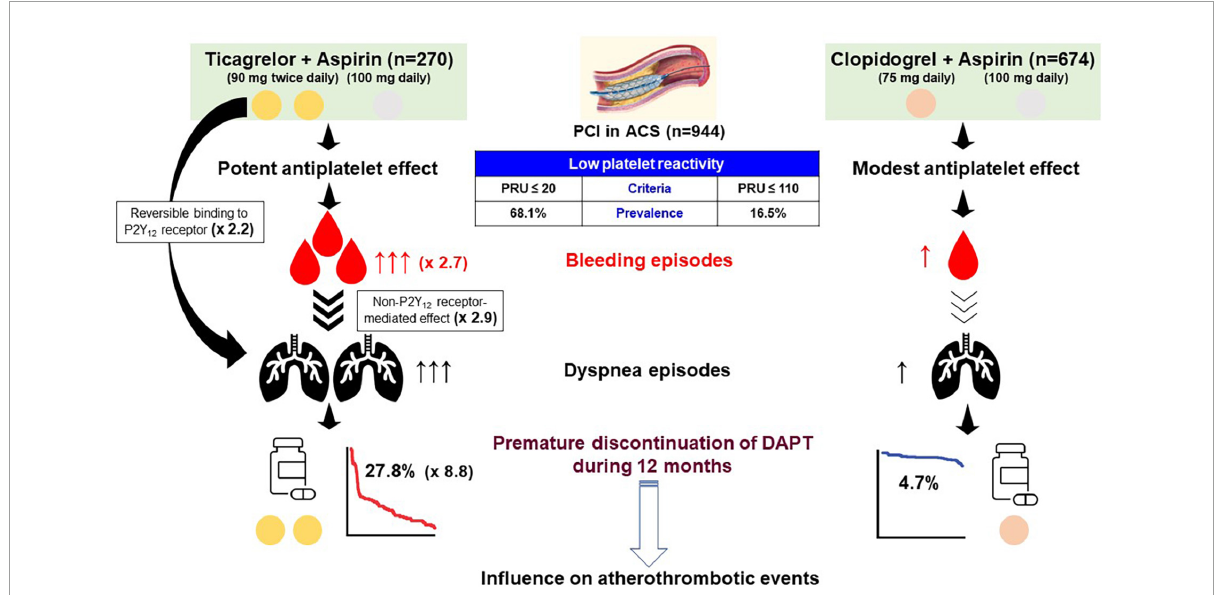
GRAPHICALABSTRACT Central illustration. Association between type of P2Y12 inhibitor, adverse events and premature discontinuation of DAPT. After dual antiplatelet therapy (DAPT) with P2Y 12 inhibitor plus aspirin, patients presented with acute coronary syndrome (ACS) were treated with percutaneous coronary intervention (PCI). Interestingly, the cutoffs of low platelet reactivity (LPR) related with bleeding episodes were different between reversibly (ticagrelor) vs. irreversibly binding P2Y 12 receptor inhibitor (clopidogrel) (P2Y12 reaction [PRU] units measured by the VerifyNow P2Y12 assay: ≤ 20 vs. ≤ 110). However, prevalence of LPR was much higher during ticagrelor vs. clopidogrel treatment (68.1% vs. 16.5%). Dyspnea during 1-month DAPT with ticagrelor was associated with reversible binding to P2Y 12 receptor by ticagrelor itself and non-P2Y 12 receptor-mediated effect. Early occurrence (within 1 month) of bleeding and dyspnea appeared to have the synergistic impact on premature switch or discontinuation of DAPT. Finally, premature discontinuation of DAPT may be related with a worse clinical outcome after